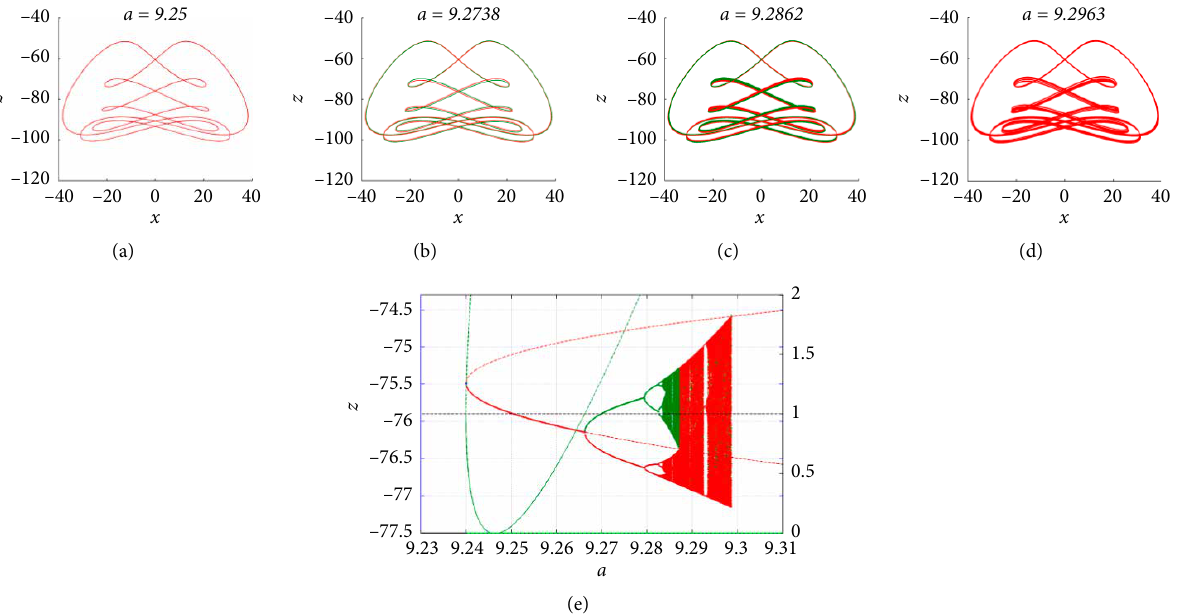
Figure 7: Limit cycle with period-5 and its bifurcation.